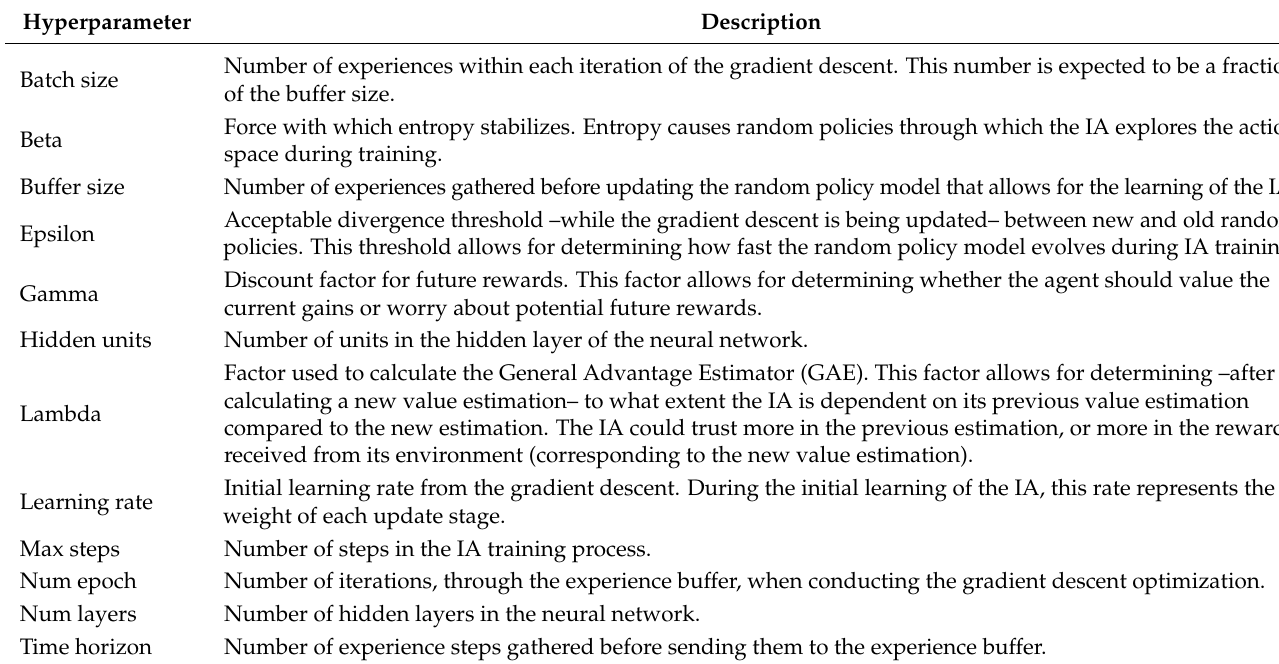
Table 7. Hyperparameters and their descriptions.